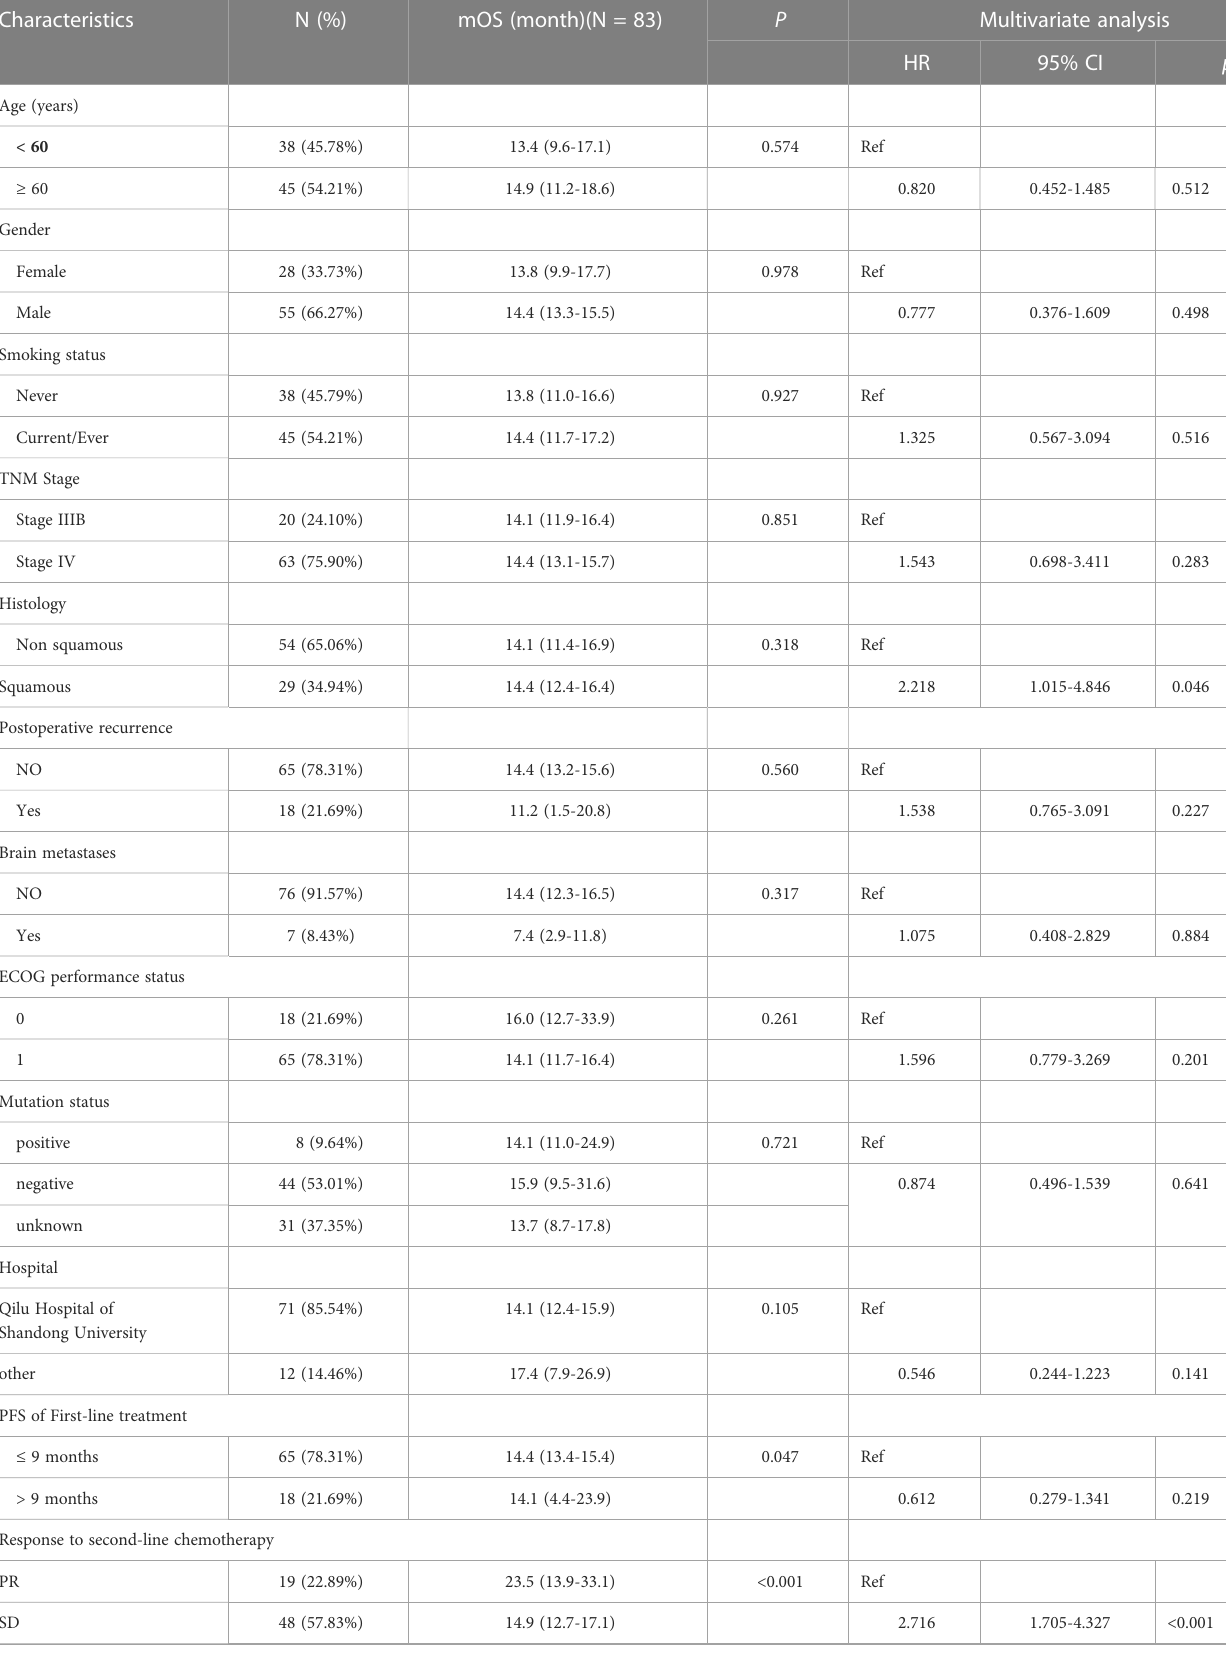
TABLE 3 Univariate and multivariate Cox regression analysis of OS in 83 advanced NSCLC receiving S-1 based doublet as second line treatment.